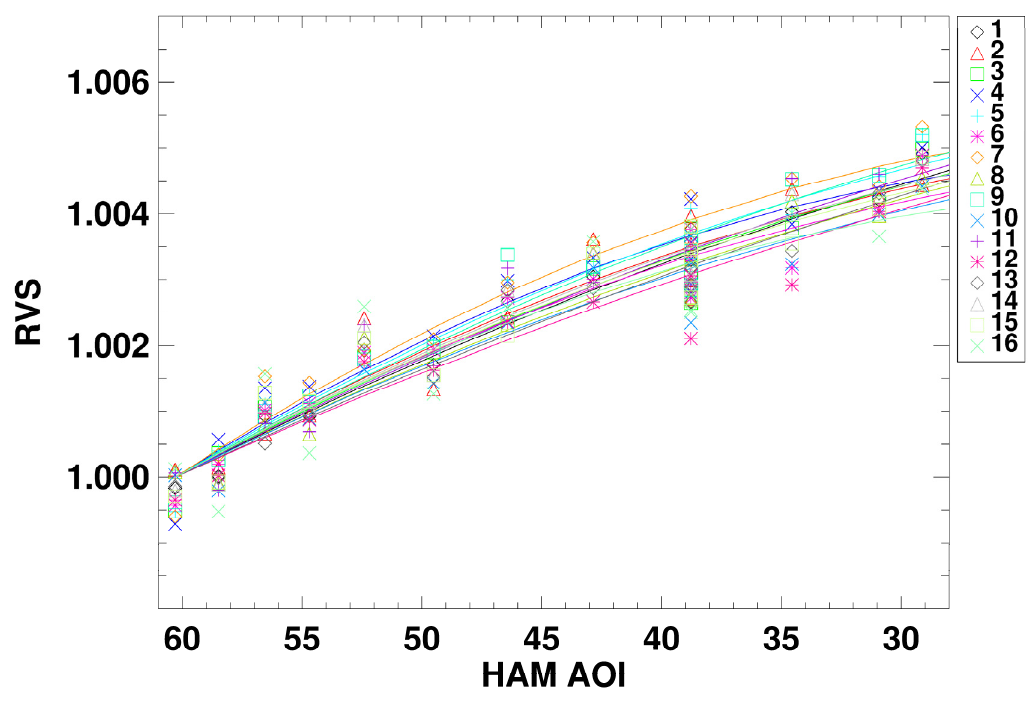
Figure 15. Band M12 HAM side A RVS Response and Fits for all Detectors.